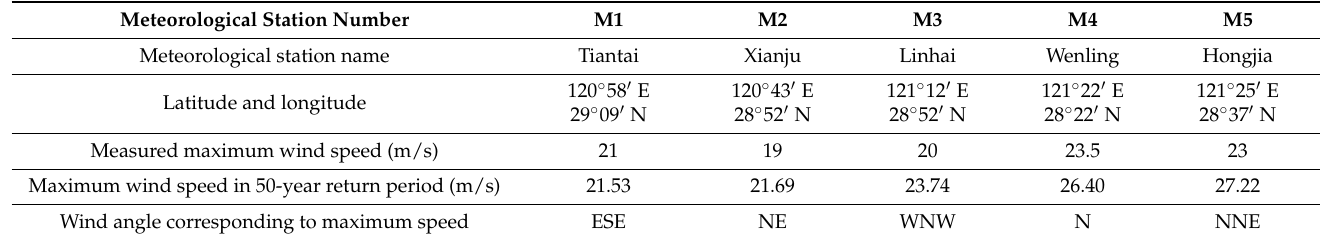
Table 2. The information of the M1 to M5 meteorological stations (referred as the five main stations).